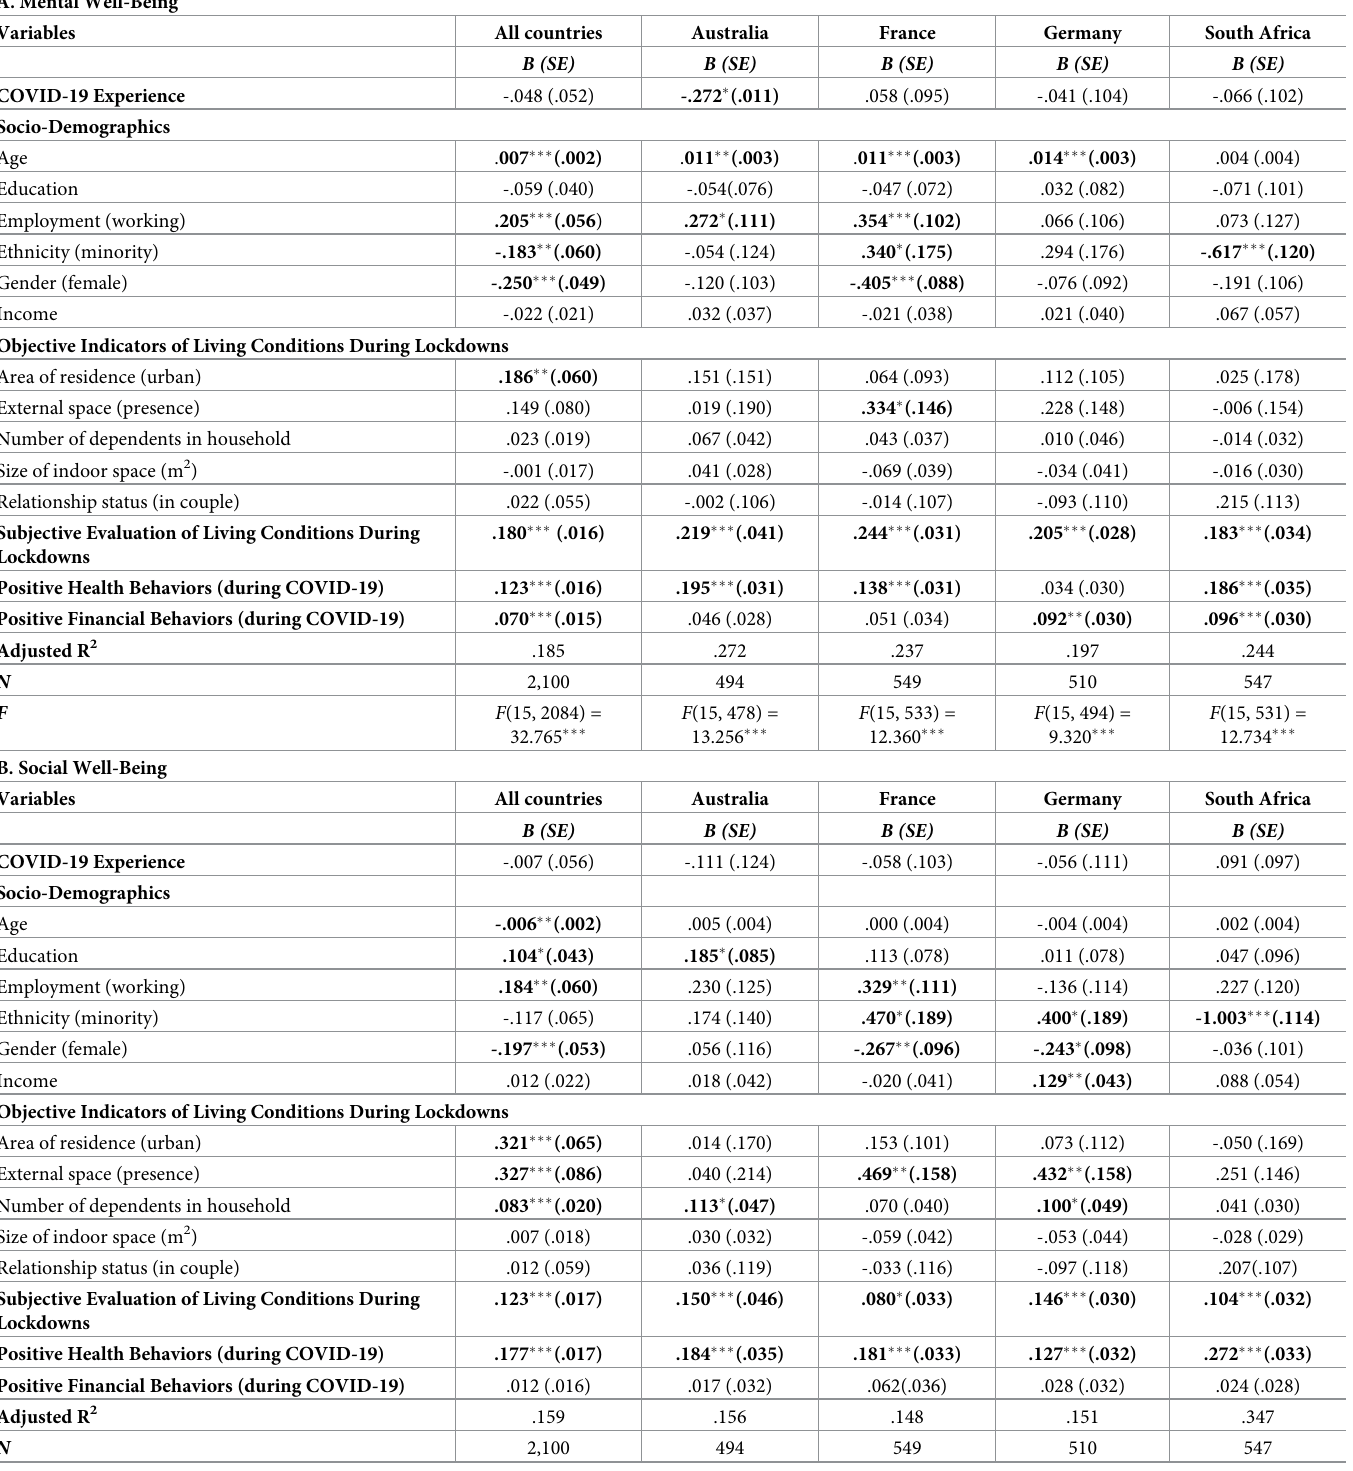
Table 7. Regressions explaining the drivers of survey respondents’ well-being during the COVID-19